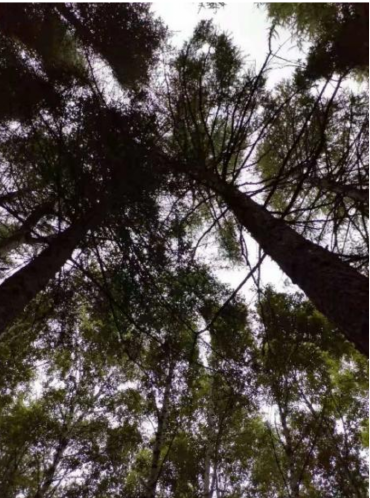
Figure 6. Trees crossing each other.